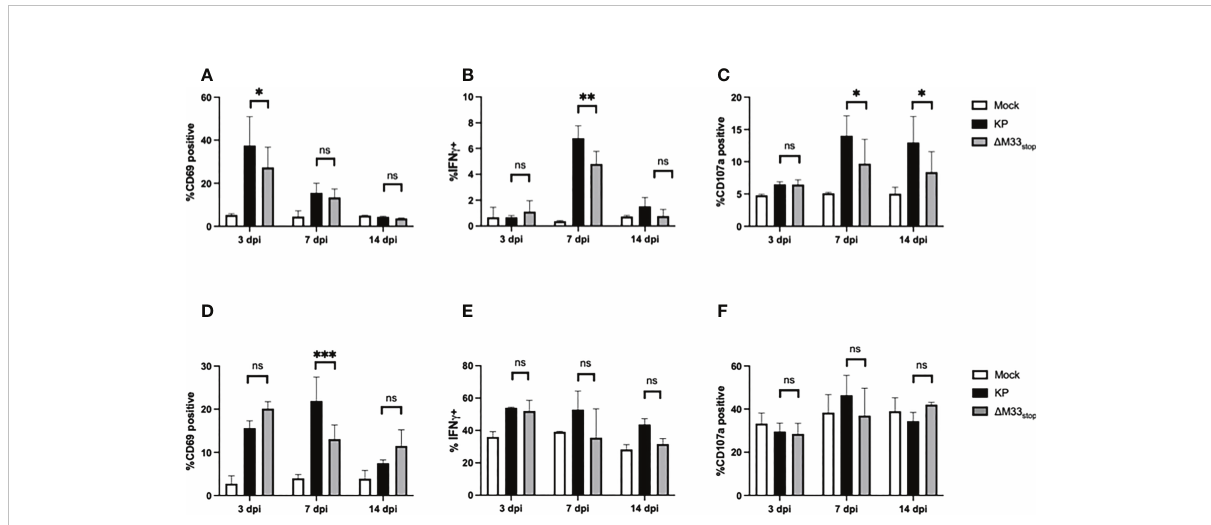
FIGURE 3 CD8 + T cell responses to acute infection with KP and D M33 stop. BALB/c ByJ mice were infected with KP or D M33 stop and sacri fi ced at the indicated time points. (A-C) CD3 + CD8 + lymphocytes were isolated from the spleen, stained with fl uorescent antibodies, and analyzed by fl ow cytometry. CD69 (A) , IFN g (B) , and CD107a (C) are shown. (D-F) CD3 + CD8 + lymphocytes were isolated from the lung as above. CD69 (D) , IFN g (E) , and CD107a (F) are shown. Pairwise comparisons are shown only between KP and D M33 stop . Experiments were conducted in duplicate with at least 4 animals per group (n = 8). Signi fi cance shown as *, p< 0.05; **, p<0.01; ***, p<0.001; ns, not signi fi